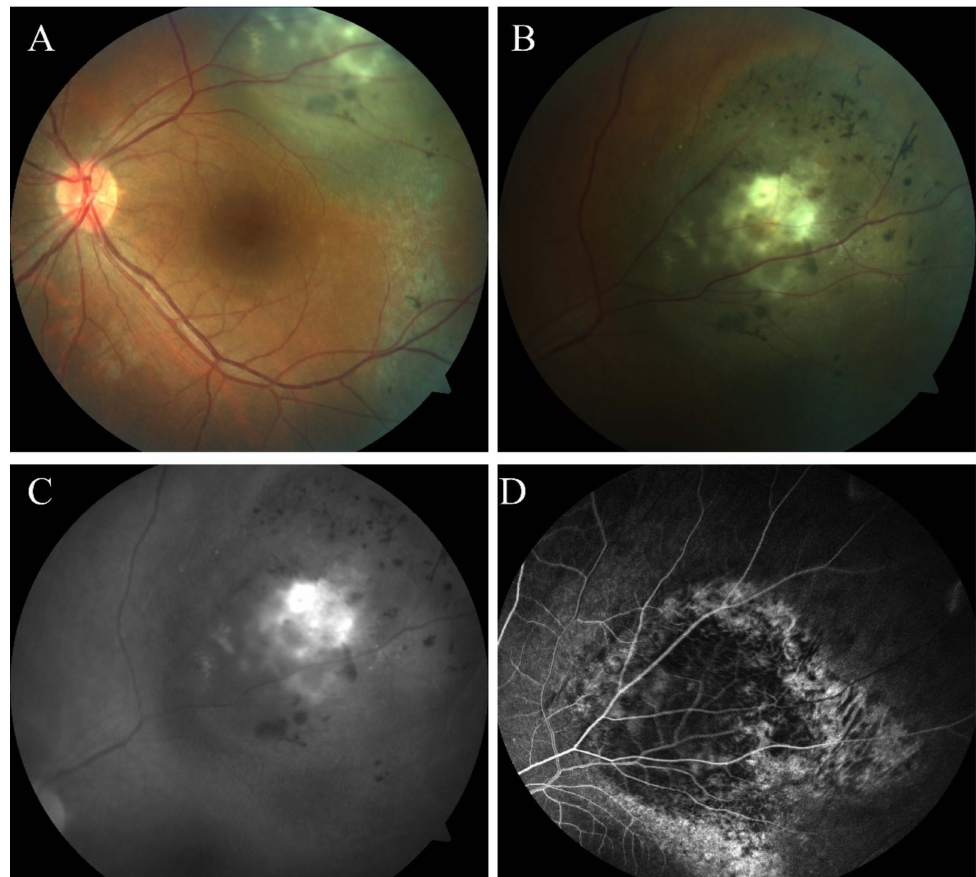
Figure 6. A 30-year-old female with left melanotic choroidal melanoma ( A ). The clinical exam showed RPE hyperplasia and metaplasia, indicating underlying previous choroidal nevus ( B ). The lesion has orange pigment lipofuscins that showed fundus autofluorescence ( C ), and the mass was associated with intrinsic vascularity in FFA ( D